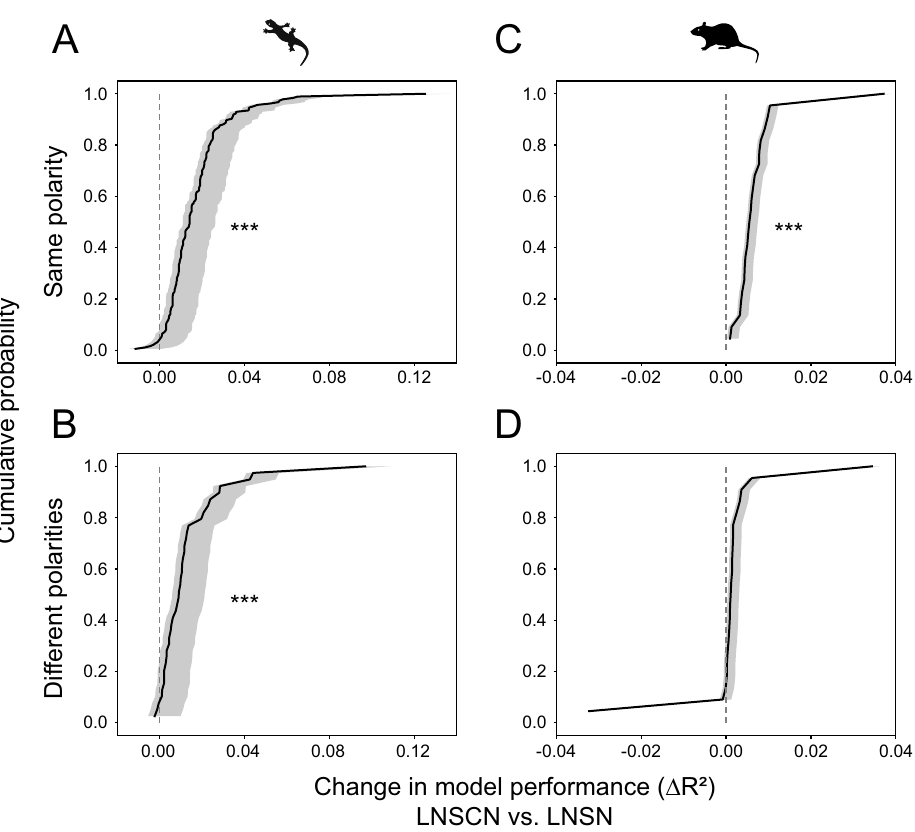
Fig 2. Coupling model outperforms non-coupling model. Cumulative probability distributions (black; confidence intervals at 5 and 95 percentiles from perturbation analysis in gray; see Methods for details) of the LNSCN model performance gain over LNSN model for salamander ganglion cells, calculated as a difference of the coefficients of determination ( R 2 , Eq (3) in Methods; see also S1 Fig). (A, B) The LNSCN model outperforms the LNSN model more with the neighboring cells of the same response polarity (A; N = 185 OFF cells with OFF neighbors; Δ R 2 = 0.017 ± 0.016, mean ± standard deviation; p < 0.001, paired t-test) than with those of different polarities (B; N = 35 OFF cells with ON neighbors and 4 ON cells with OFF neighbors; Δ R 2 = 0.013 ± 0.017; p < 0.001): p = 0.006 from Kolmogorov-Smirnov test. Here and thereafter, three stars ( ??? ) indicate p < 0.001; ?? , p < 0.01; and ? , p < 0.05. (C, D) Corresponding figure panel for the mouse ganglion cells. The LNSCN model outperforms the LNSN model when the neighboring cells of the same response polarity are included (C; N = 10 ON cells with ON neighbors and 12 OFF cells with OFF neighbors; Δ R 2 = 0.007 ± 0.007; p < 0.001), but not with the neighboring cells of different polarities (D; N = 10 ON cells with OFF neighbors and 12 OFF cells with ON neighbors; Δ R 2 = 0.001 ± 0.010; p > 0.5): p < 0.001 from Kolmogorov-Smirnov